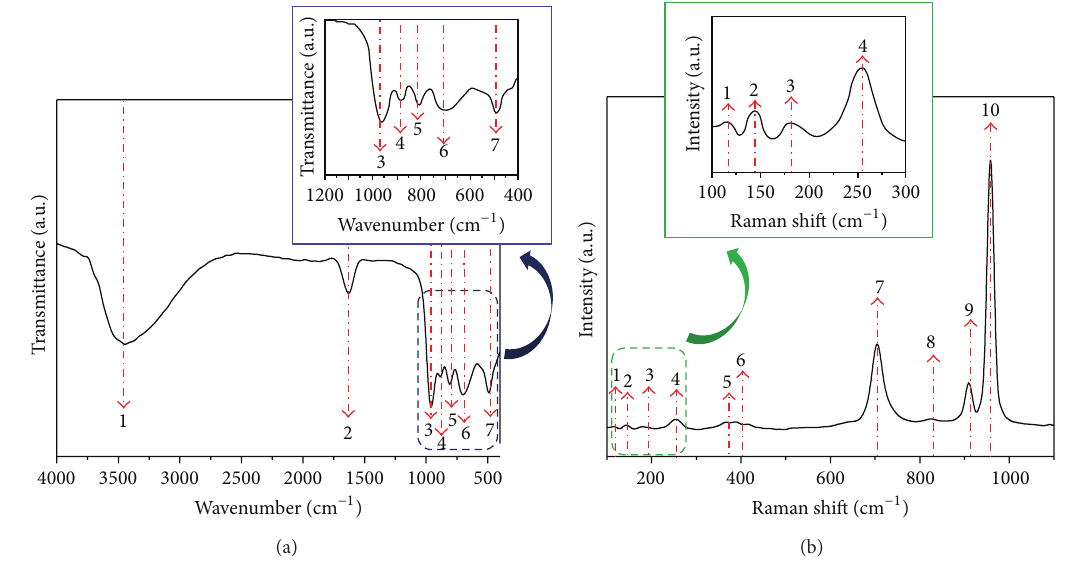
Figure 3: (a) FTIR and (b) FT-Raman spectra of the 𝛼 , 𝛽 -NiMoO 4